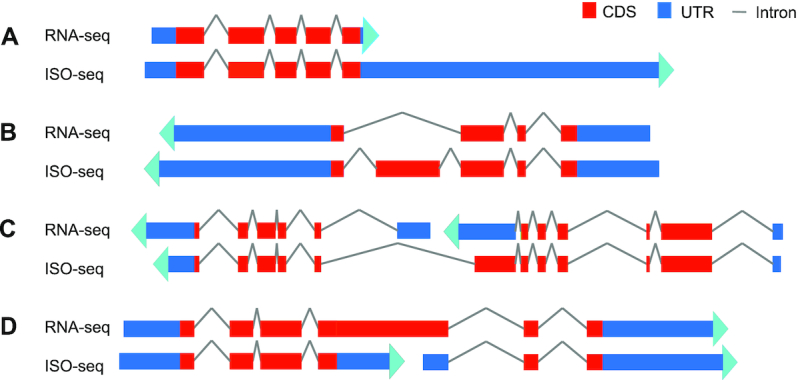
Comparison of RNA-seq and ISO-seq gene annotations. (A) UTRs newly annotated in ISO-seq annotation. (B) Genes annotated incompletely by missing exons in RNA-seq annotation. (C) One gene was misannotated to multiple genes in RNA-seq annotation. (D) Two genes were misannotated as a combined gene in RNA-seq version but were correctly annotated in ISO-seq data. CDS, coding sequences; UTR, untranslated region.